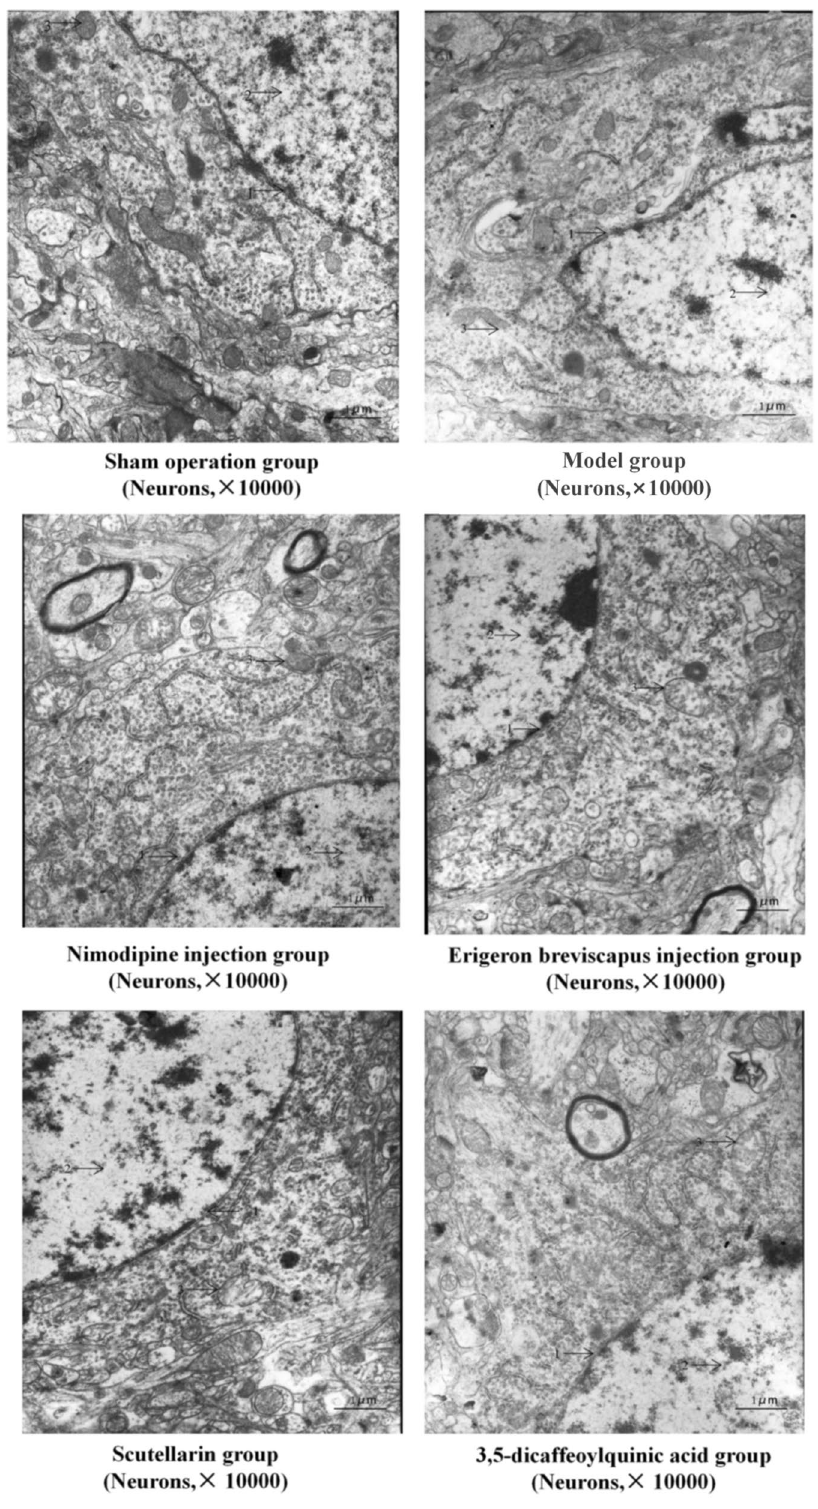
Figure 10. Ultrastructure of neurons in the ischemic brain tissue of rats: 1. nuclear membrane; 2. nuclear chromatin; and 3. mitochondria and other organelles in the